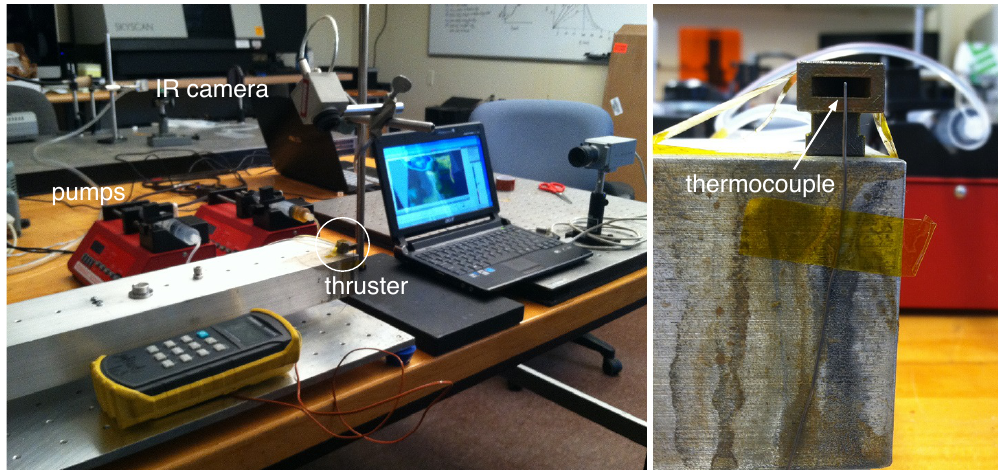
Figure 12. ( Right ) Photograph of DMLS stainless steel nozzle used for plume temperature measurement. A type K thermocouple was placed directly in the center of the nozzle exit for temperature measurements. ( Left ) Photograph of entire experimental set-up including thermal imaging camera, video camera, and digital